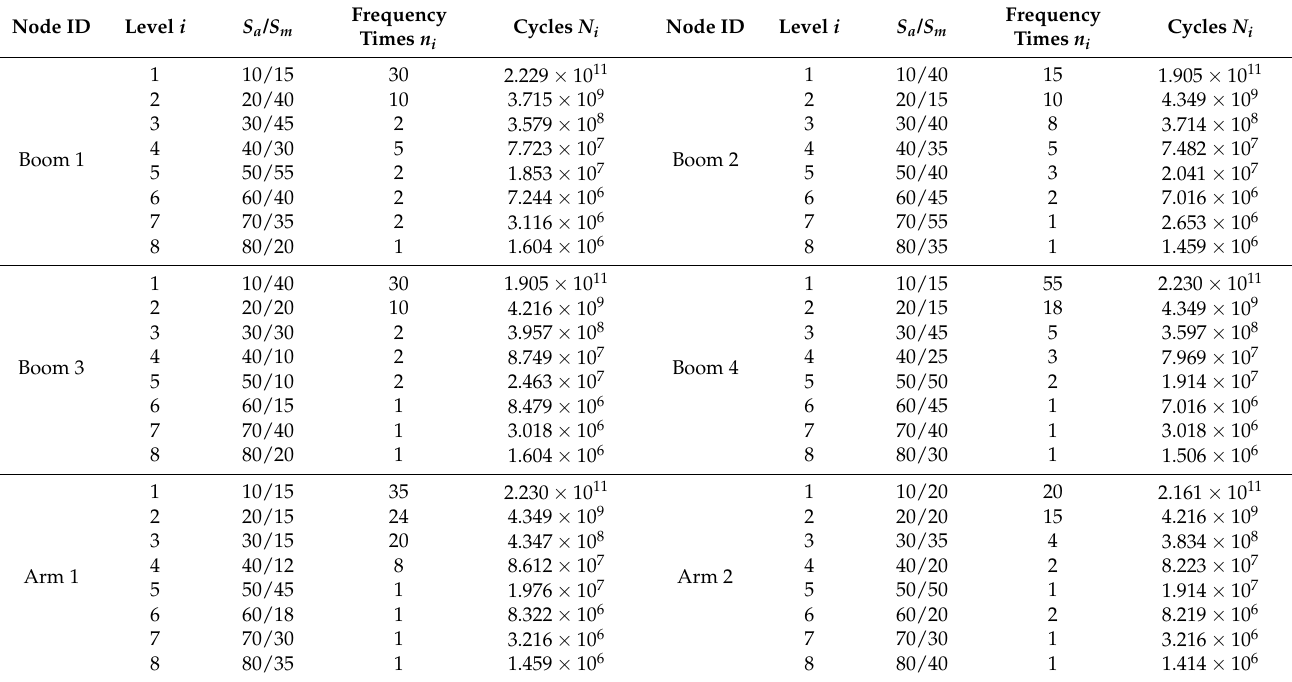
Figure 17. The corrected S-N curve of the 16Mn affected by the welding heat. 6.8. The Fatigue Life Prediction on the Remanufactured Excavator Beam In this case, the stress at crisis nodes is divided into 8 levels depending on the ratio of the amplitude to the mean. The stress amplitude S a , the mean stress S m and the frequency times n i at a stress level at the crisis nodes on the beam during a working cycle are computed by RFC, depending on the stress spectra at the corresponding nodes. Subsequently, the amplitude S a and the mean stress S m are substituted into Equations (35) and (36) to calculate the number of cycles N i at each stress level. The computed cycles on stress levels at crisis nodes depending on the stress frequency spectra and the corrected S-N curve of the remanufactured welding material are listed in Table 6. Table 6. Computed cycles on stress levels at crisis